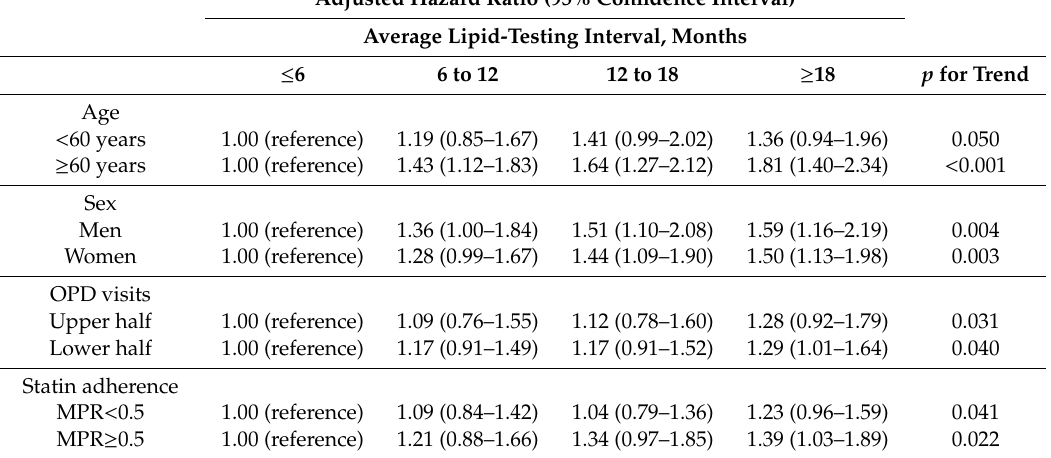
Table 3. Stratified analysis on the e ff ect of average lipid-testing interval on total stroke among newly diagnosed dyslipidemia patients according to subgroups of age, sex, outpatient department visits, and statin